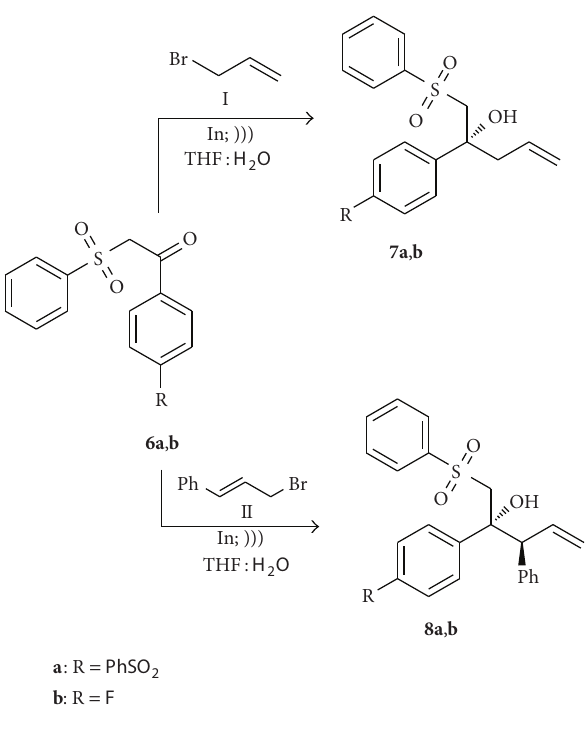
S 4: Synthesis of homoallylic alcohols 7a,b-8a,b under ultrasonic irradiation or conventional